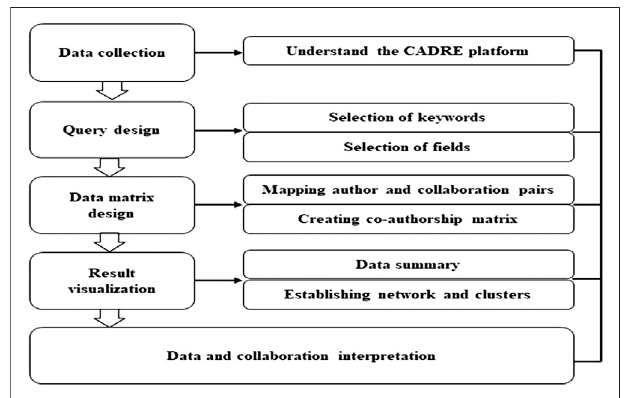
FIGURE 1 | Steps of collaboration analysis used in SDG-related